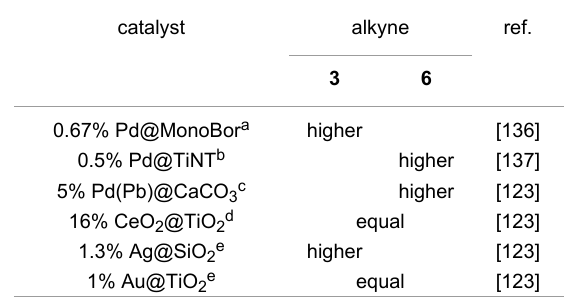
Table 3: Relative selectivity in the continuous-flow partial hydrogena- tion reaction of 3 and 6 at comparable conversion